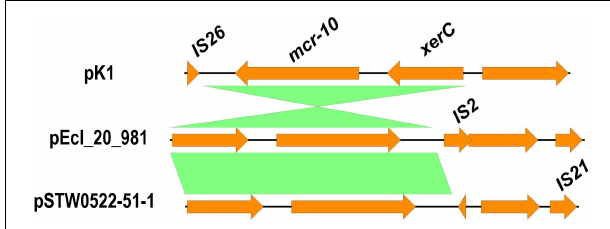
FIGURE 2 | Schematic representation of the genetic environments of mcr-10 identified from the draft genome sequence of K. pneumoniae isolate (K1). The figure was drawn using the EasyFig tool